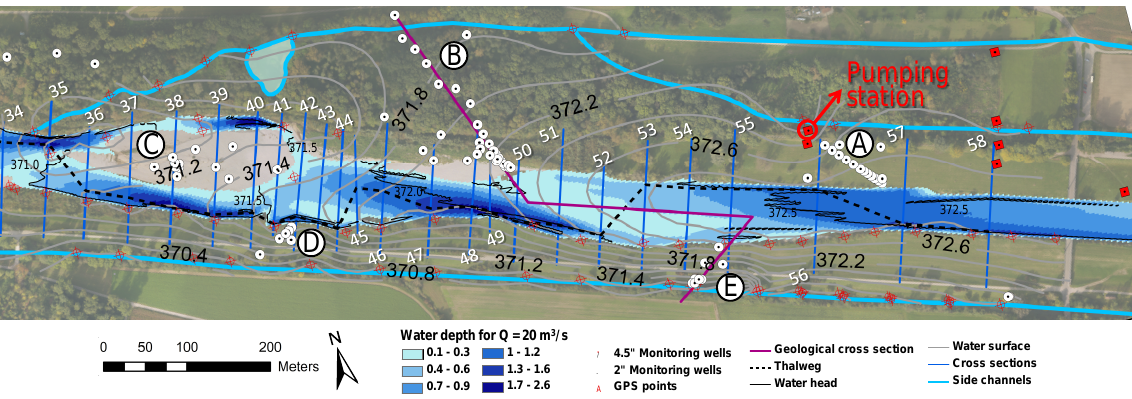
Fig. 2. Test site Neunforn, partly restored (left) and partly channelized (right) with monitoring-well transects A, B, C, D, E (Table 3). Thalweg (dashed black line), surface water levels (solid black line) and water depths (blue color coded) for River Thur under low-flow conditions (20m 3 s − 1 ). Contourlines of groundwater heads (light grey solid lines) are based on interpolated surface-water levels in the river (measured at flows of approximately 30m 3 s − 1 ) and the side channels with a differential GPS (red crosses). Bathymetric surveys are conducted annually in September by measuring predefined cross-sections blue lines with white